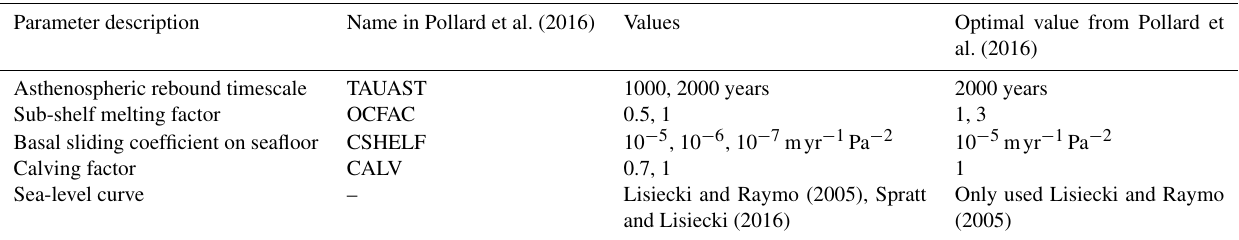
Table 2. Parameter choices for ice sheet model